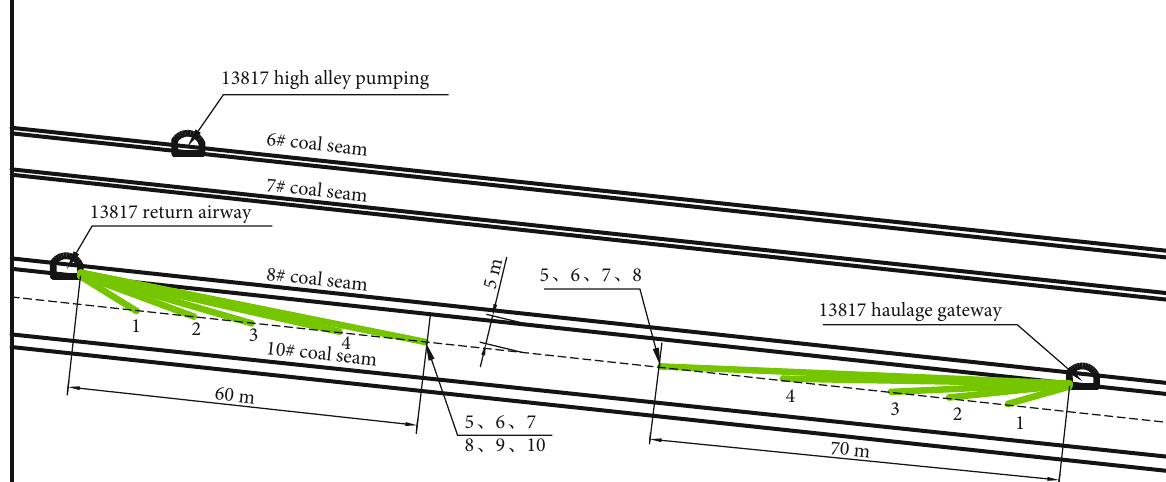
Figure 20: Borehole pro fi le of fl oor crossing layer of 13817 mining face.